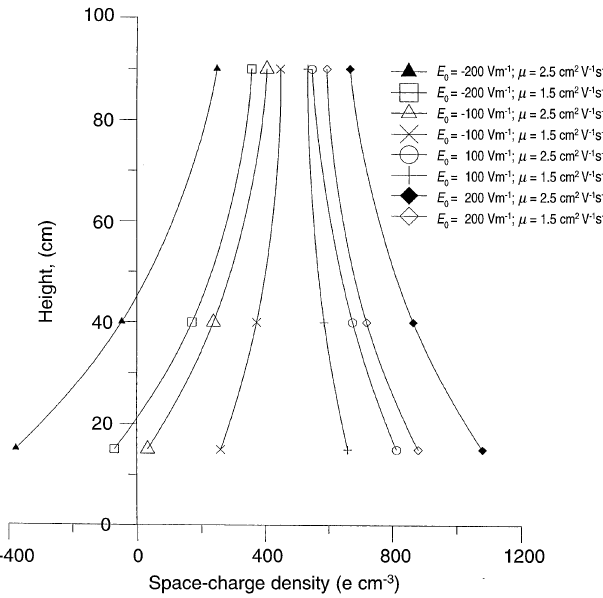
Fig. 4. Theoretical profiles of space-charge density ( E — electric field strength, (cid:107) — the small-ion mobility)